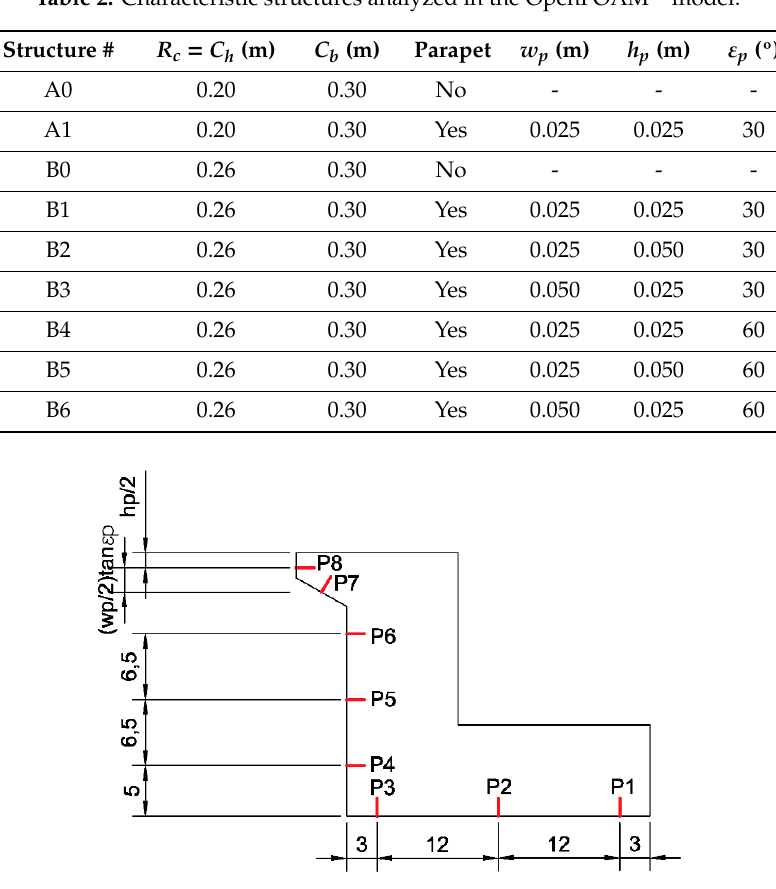
Figure 6. Pressure sensors placed in the crown wall with a parapet. Dimensions are presented in centimeters.